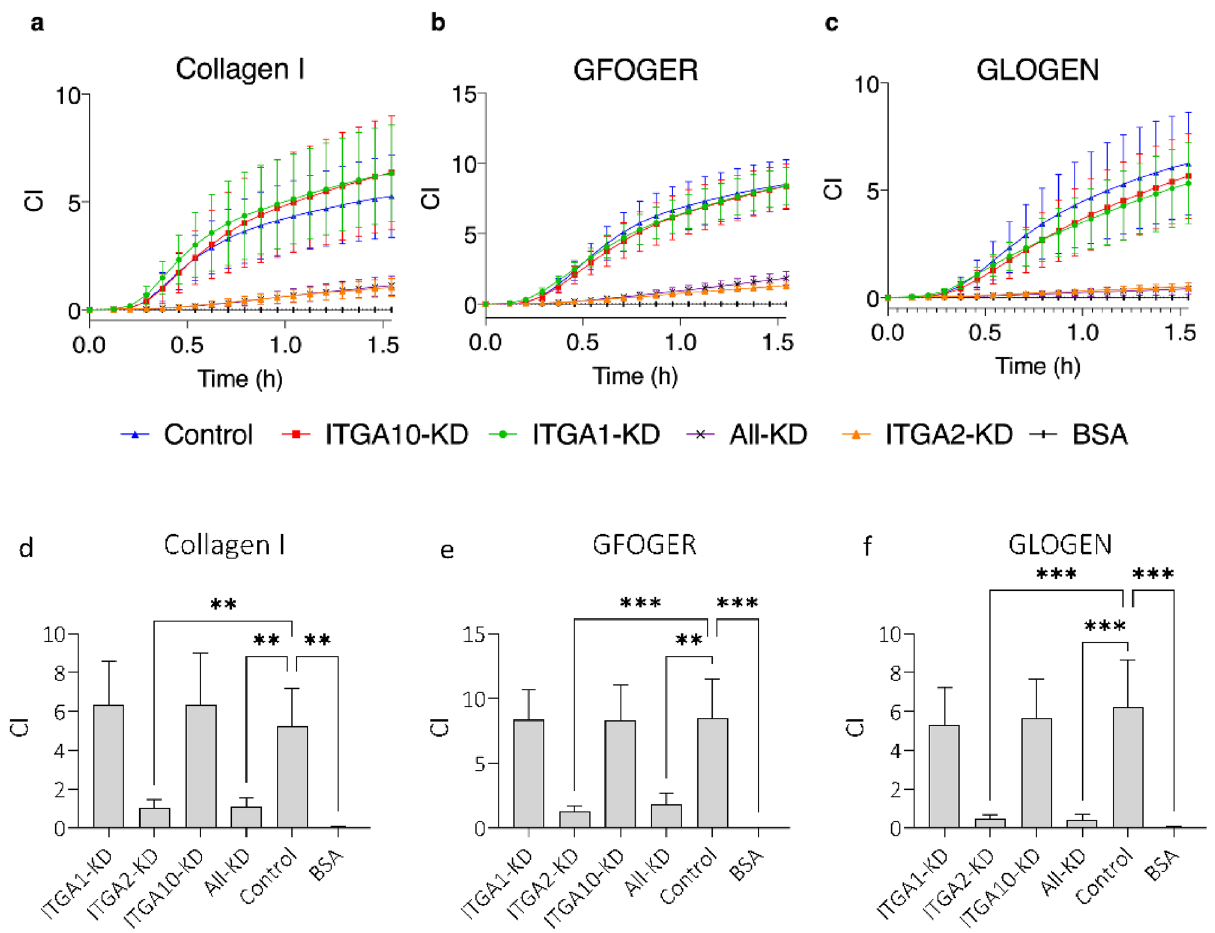
Figure 5. Real-time adhesion of HUVECs to collagen or peptides 48 h post siRNA treatment using xCELLigence. Wells were coated with either ( a ) collagen I, ( b ) GFOGER or ( c ) GLOGEN. The cell index was measured every 5 min. ITGA1-KD (green), ITGA2-KD (orange), ITGA10-KD (red) and All-KD (purple) indicate siRNA knockdown for the transcripts that code for the integrin subunits α1, α2, α10 and the triple knockdown respectively. Control (blue) denotes transfection with the siRNA negative control. BSA (black) shows cell attachment to BSA blocked wells as a baseline. Corresponding mean endpoint adhesion data is shown in ( d–f ) and statistical significance was determined using two-way ANOVA. Error bars in all panels indicate SEM calculated from three repeats performed in